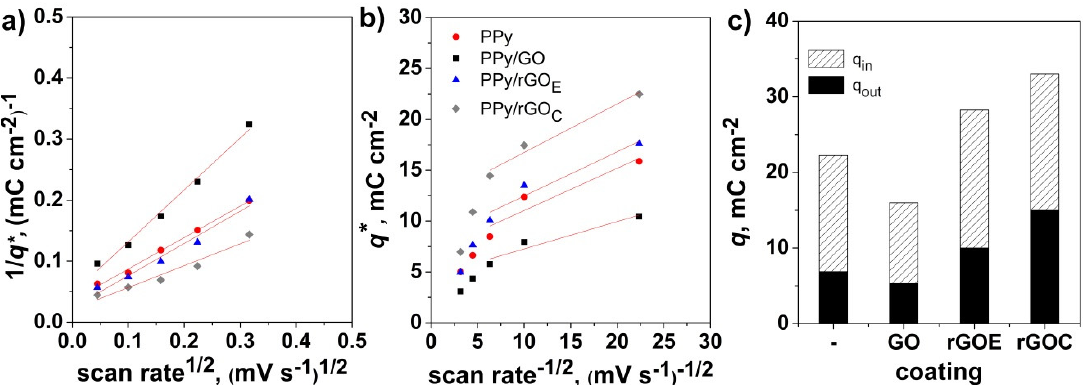
Figure 7. Inverse voltammetric charge vs. the square root of the scan rate ( a ), voltammetric charge vs. the inverse square root of the scan rate ( b ), and the contribution distribution to the total charge from the inner (qin) and outer (qout) charges ( c ) as a function of the electrode material.